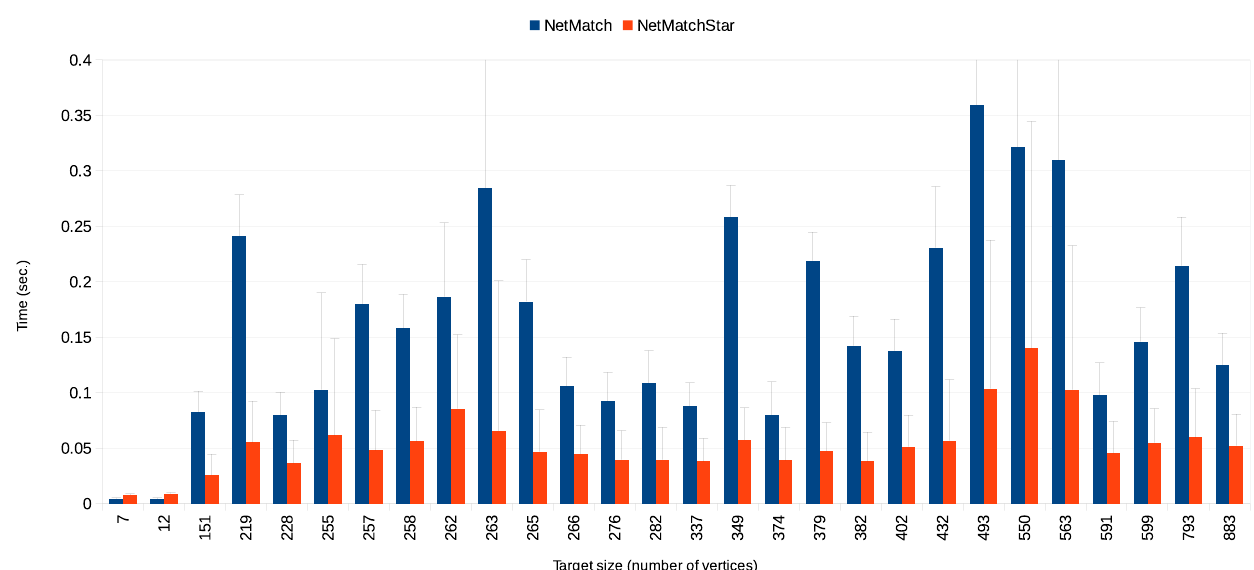
Figure 7. Query execution time on 3d-proteins.